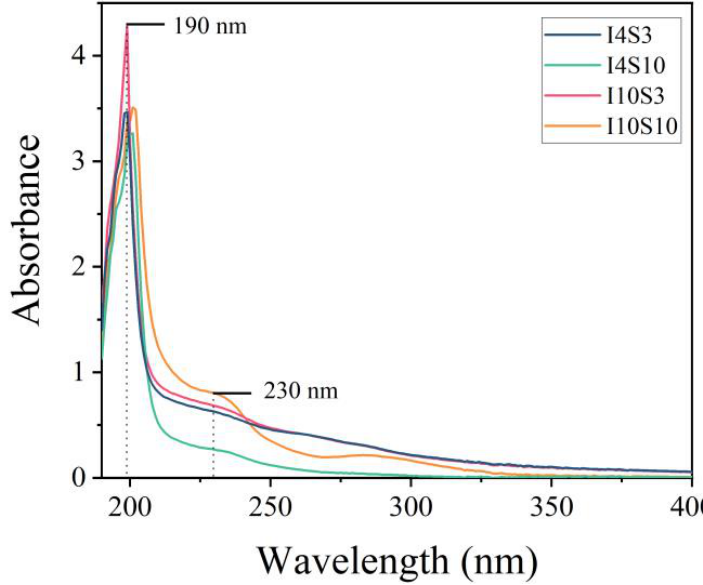
Figure 7. UV spectra of specimens recycled from NaCl electrolyte.